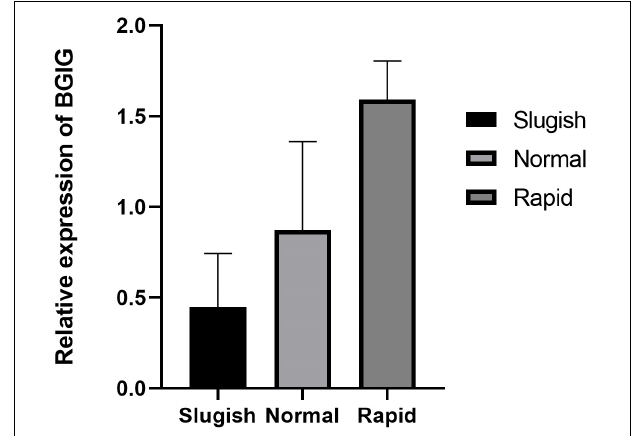
FIGURE 6 | The relative expression of BGIG in different premature ejaculation